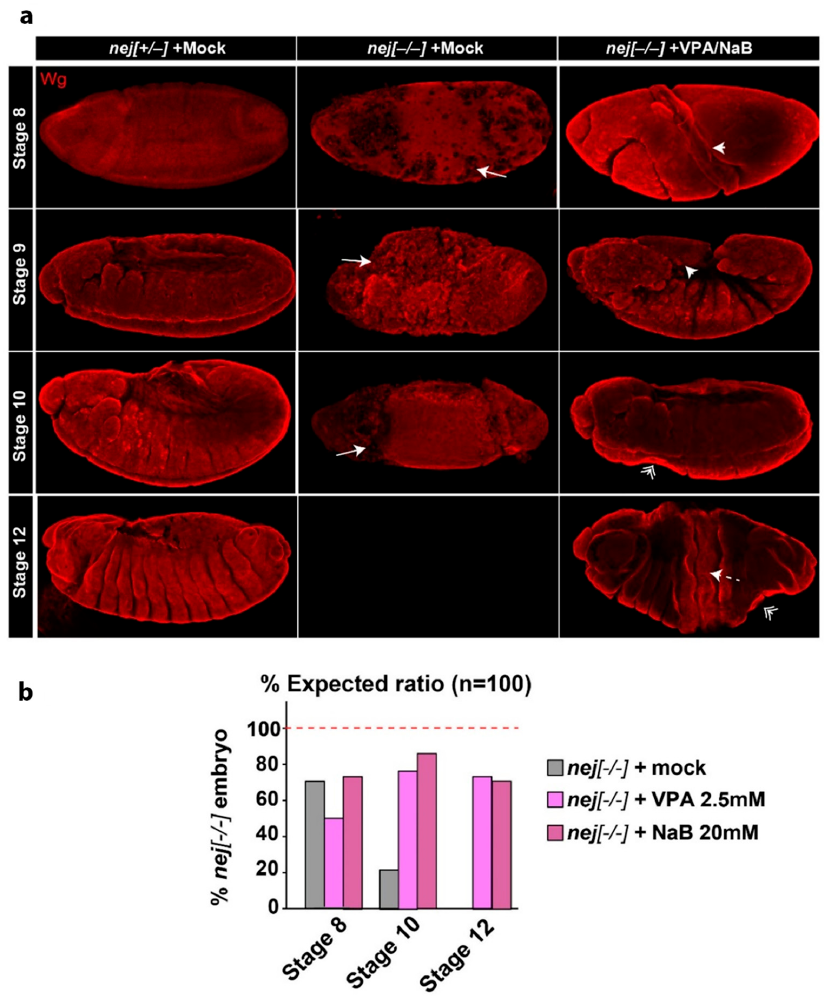
Figure 3. Developmental and morphological defects in nej mutant embryos are partially ameliorated by VPA or NaB treatment. ( a ) wingless (wg) staining of nej mutant embryos treated as indicated. Representative projections of confocal imaging from stages 8 to 12 are shown. The defects detected in nej mutant embryos with or without treatment include loss or uneven wg staining (Drilled, arrow), twisting (arrowhead), presence of bottlenecks (double-arrowheads), or cracks (dashed-arrow). ( b ) Quantification of embryo survival and of the above phenotypes in nej mutant embryos at stages 8 to 12. VPA or NaB treatments partially rescue embryo development, allowing nej mutant embryos to survive beyond stage 8 although with aberrant phenotypes, with significant embryo survival at stage 10 compared to untreated embryos ( p > 0.01). Student’s t-test was used as statistical method for comparing nej groups survival, with p < 0.05 considered